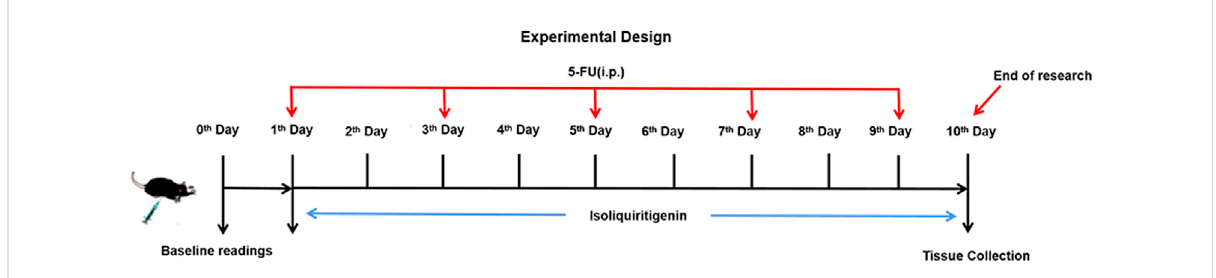
FIGURE 2 Experimental protocol for inducing intestinal mucositis in